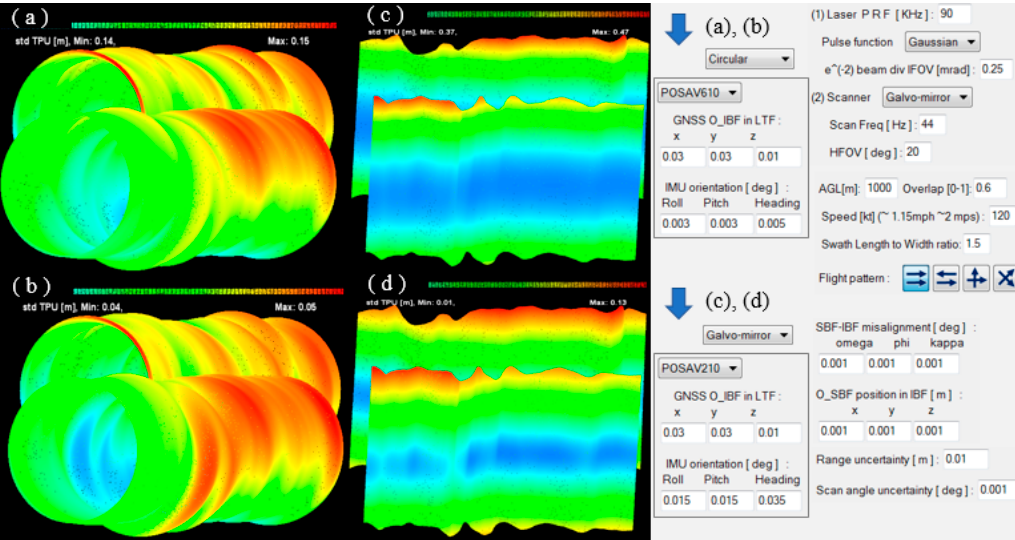
Figure 9. The simulated TPU and the uncertainty input components from the lidar simulator GUI: ( a ) Horizontal TPU with a circular scanner, ( b ) vertical TPU with circular scanner, ( c ) horizontal TPU with linear scanner, ( d ) vertical TPU with linear scanner. The corresponding parameters on graphical user interface.